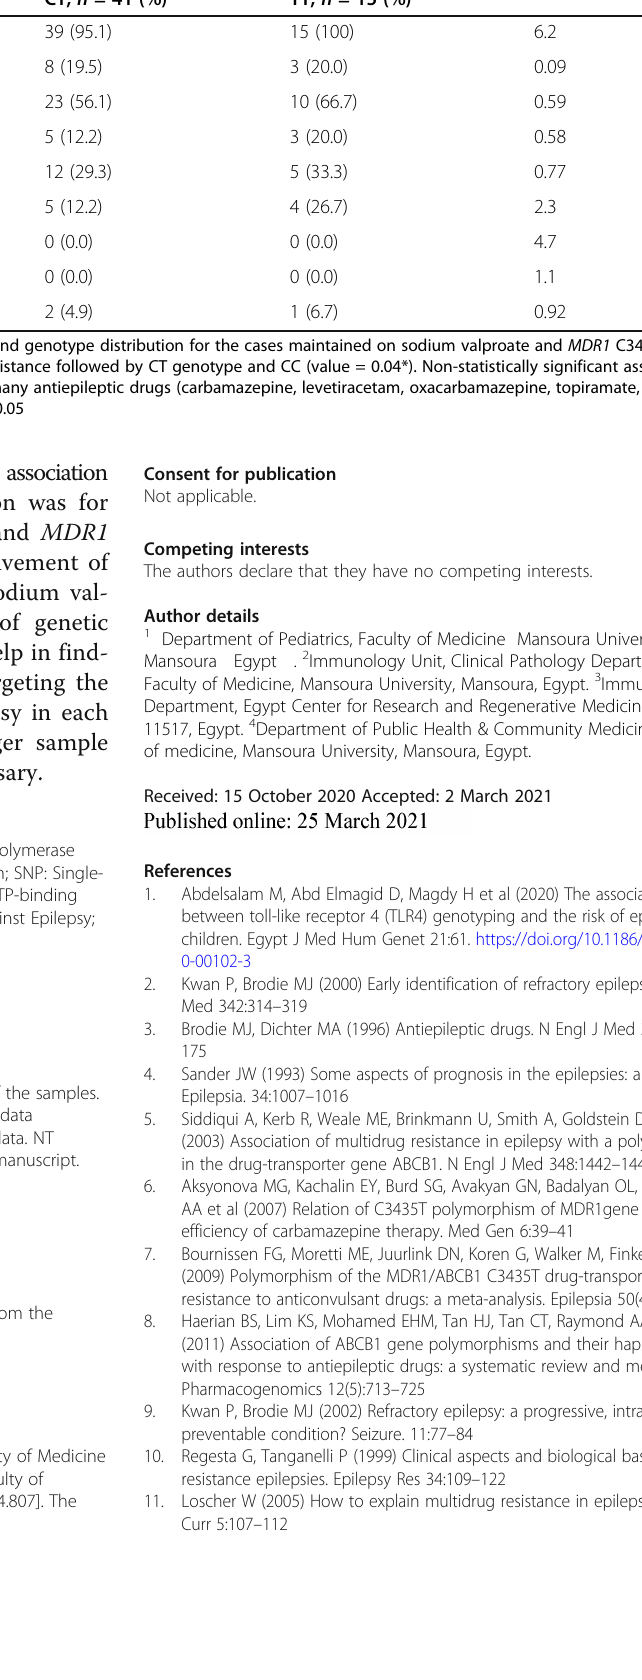
Table 8 Relation between MDR1 C3435T SNP and epilepsy drugs used Drug MDR1 C3435T